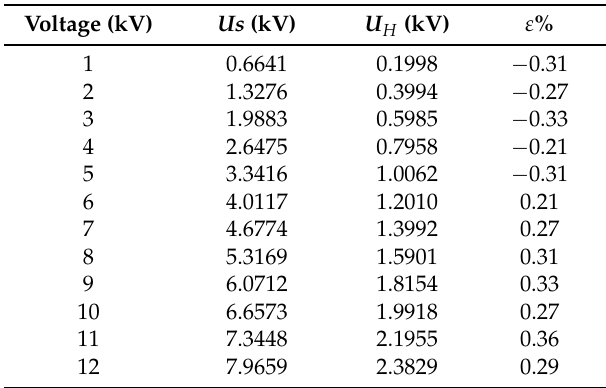
Table 8. Results of Phase